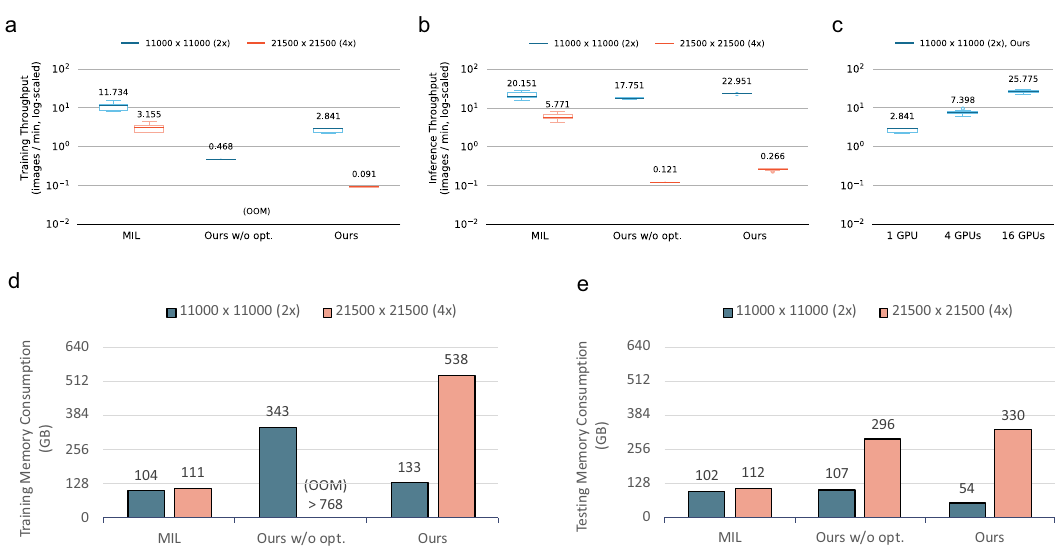
Fig. 6 Throughput and memory consumption of training and inference on our proposed method against non-optimized version and MIL. For throughput tests, we measured the execution time of 30 training iterations of each con fi guration to acquire the distribution. All boxes-and-whiskers in a – c represent a distribution with center (Q2, the median), the bounds of box (Q1 and Q3, the fi rst and third quartile), and the bounds of whisker (the minimal and maximal values within the range obtained by Q2 ± 1.5 × (Q3 – Q1)). a Training throughputs of whole-slide method, non-optimized version, and MIL on 11,000 × 11,000 (blue) and 21,500 × 21,500 (red) images with a single GPU. Note that the con fi guration of training 21,500 × 21,500 images by non-optimized whole-slide training method is not executable due to incurring out-of-host-memory error. b Inference throughputs of models with a single GPU. c Training throughputs of our method with multiple GPUs. d Host-memory consumption of our method w/ and w/o optimization and MIL on 11,000 × 11,000 (dark blue) and 21,500 × 21,500 (red) images during training phase. Training 21,500 × 21,500 images by non-optimized whole-slide training method encounters an out-of-memory error, implies the memory consumption is higher than the host-memory capacity of a node, 768 GB. e Host-memory consumption of models during inference